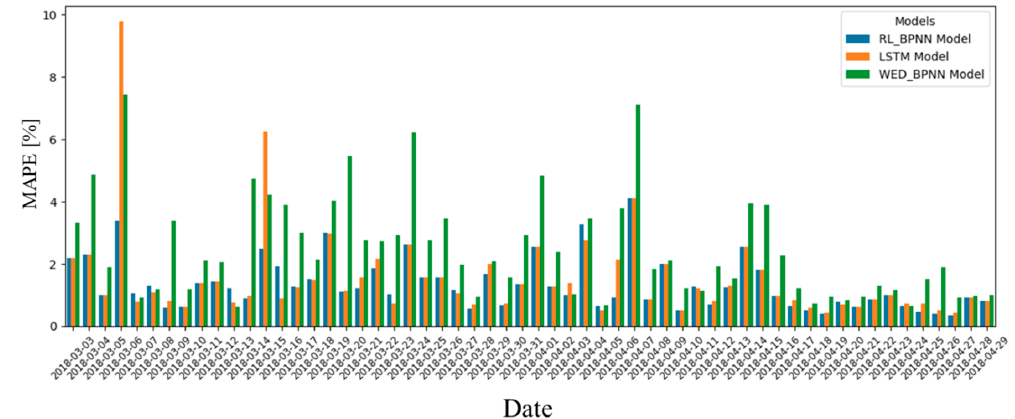
Figure 12. Mean absolute percentage error (MAPE) of the models for the simulation period.